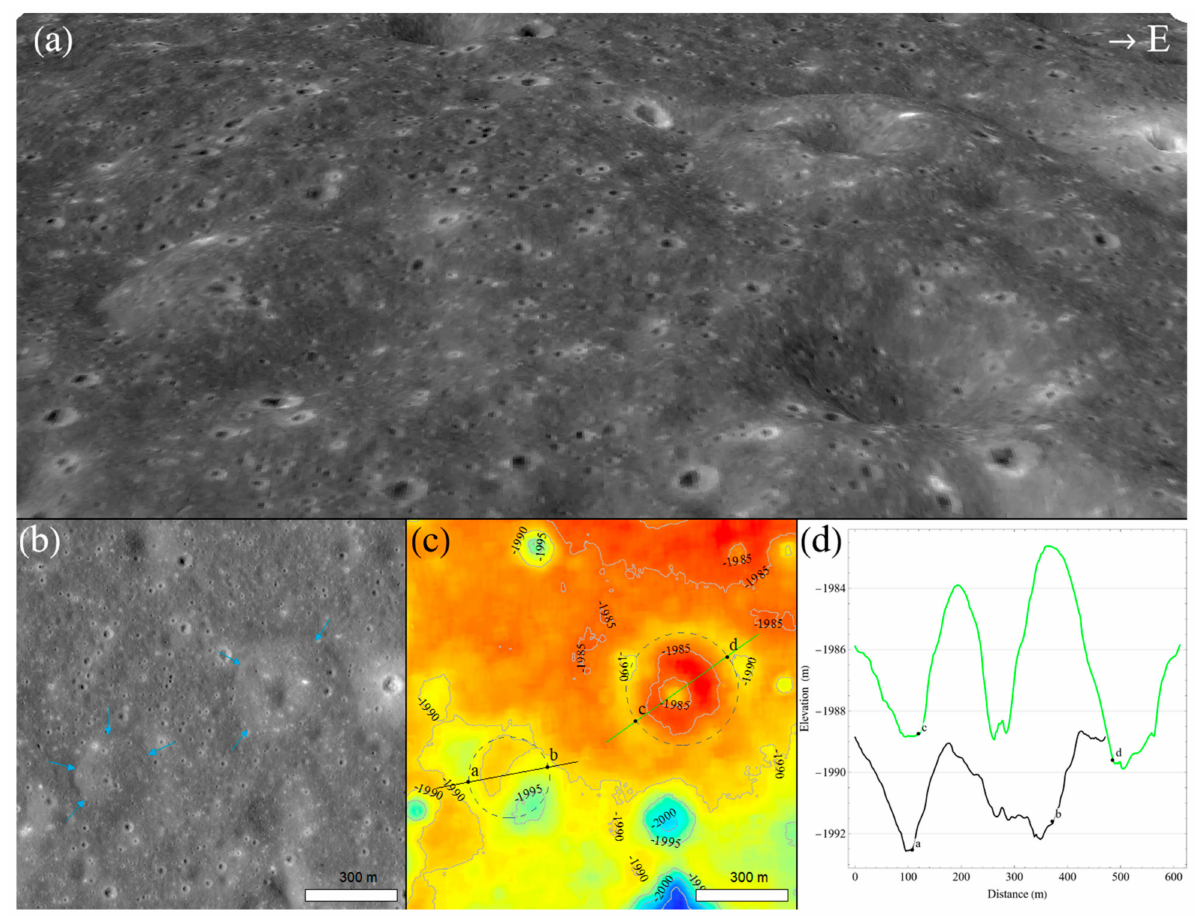
Figure 10. Two RMDSs (1.38 ◦ S, 52.27 ◦ E and 1.37 ◦ S, 52.29 ◦ E) in Mare Fecunditatis. ( a ) 3D image of these two RMDSs (five times vertical exaggeration); ( b ) NAC orthoimage; ( c ) NAC DTM; ( d ) elevation of the profiles of ( c ). Data source: NAC M1126787189LE and NAC